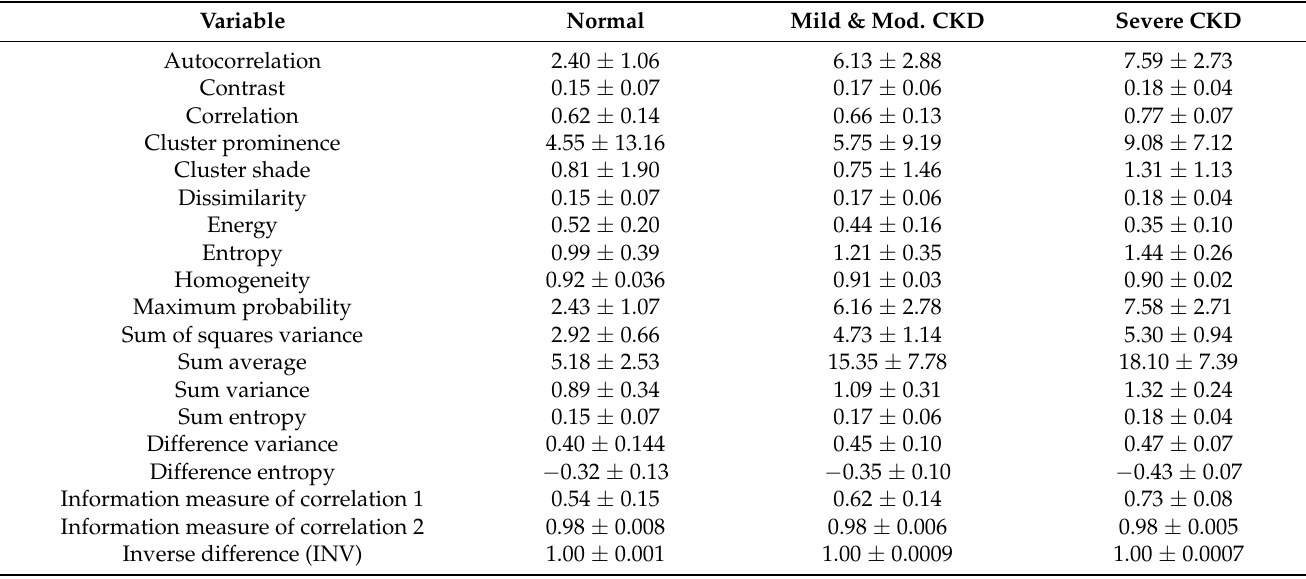
Table 4. Values of GLCM features of the cortex (mean ±